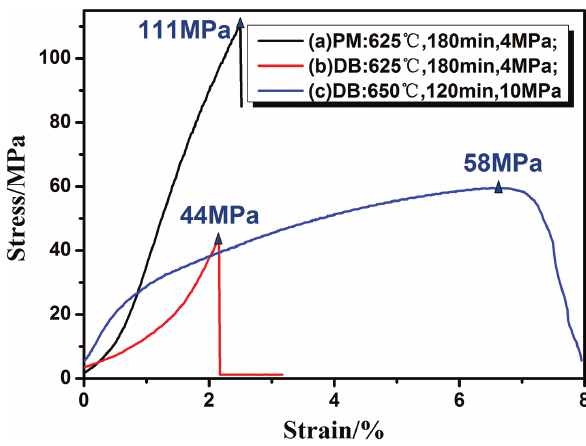
Figure 7: Stress – strain curves of tensile strength.